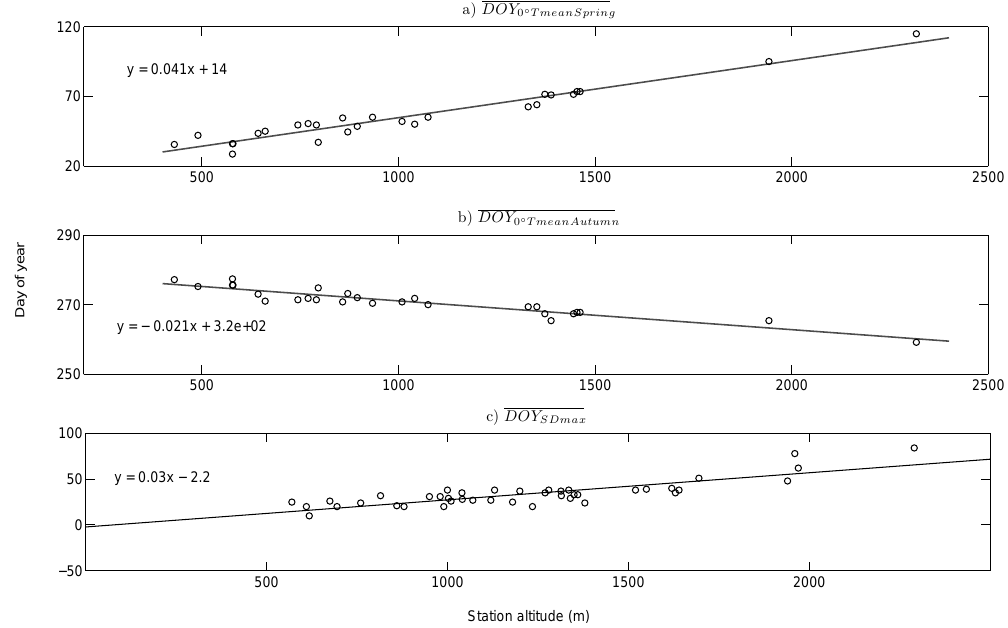
Figure 4. (a) Station altitude vs. DOY of daily T mean passing the freezing point in spring; (b) same as (a) , but for autumn; (c) station altitude vs. DOY of annual SD maximum; all graphs with the line of best fit and corresponding equation. DOYs are calculated as averages of the period